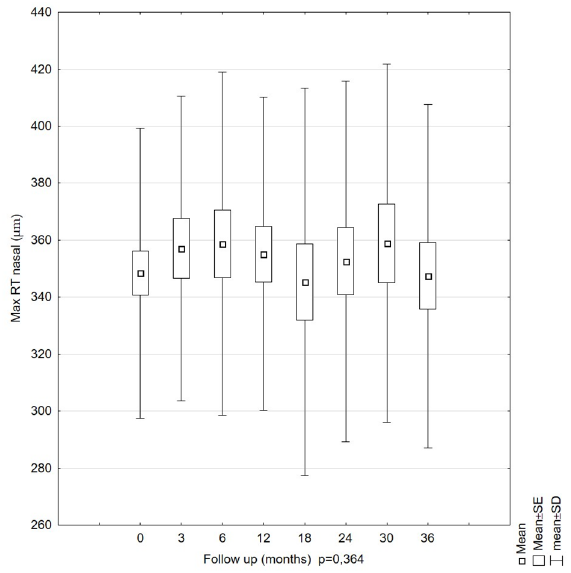
Figure 4. Mean values of the maximal retinal thickness (Max RT) for the nasal area parameter of patients during the 36-month observation period. The Max RT nasal value showed no statistically significant changes over this period.